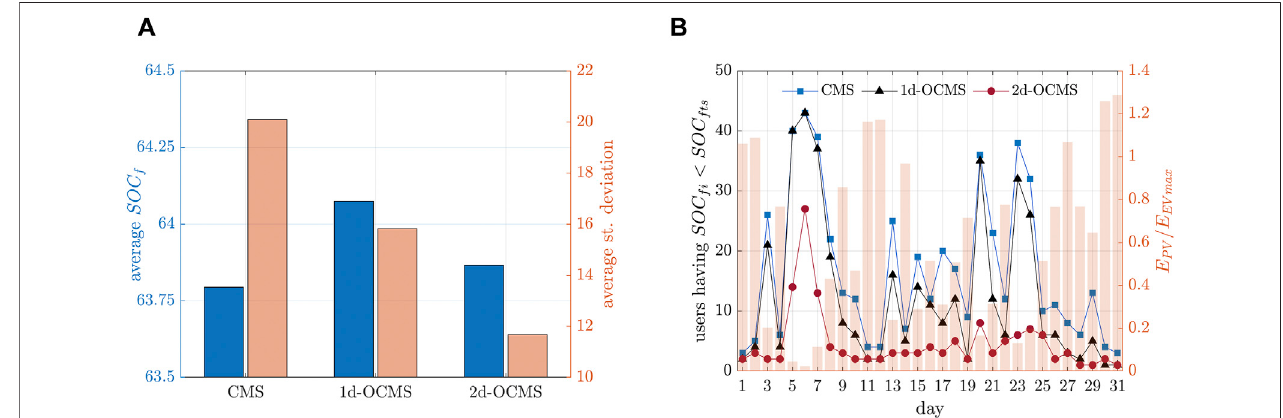
FIGURE 11 | (A) Monthly-based average SOC f (left side blue bars) and the corresponding standard deviation (right side red bars) among EVs in case of standardCMS (leftgroup) ,1d-OCMS (centergroup) ,and2d-OCMS (rightgroup) . (B) Usercountful fi lling SOC fi < SOC fts condition (left-handaxis) and E PV / E EVmax ratio (right-hand axis bar chart) over a 31-day